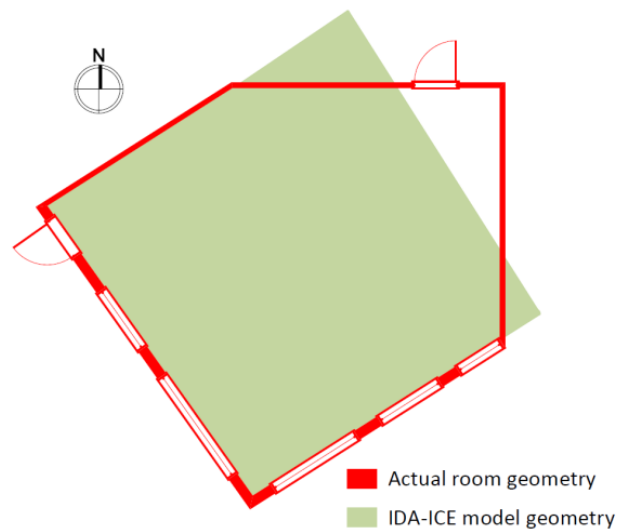
Figure 10. Actual and modeled geometries of the classroom.